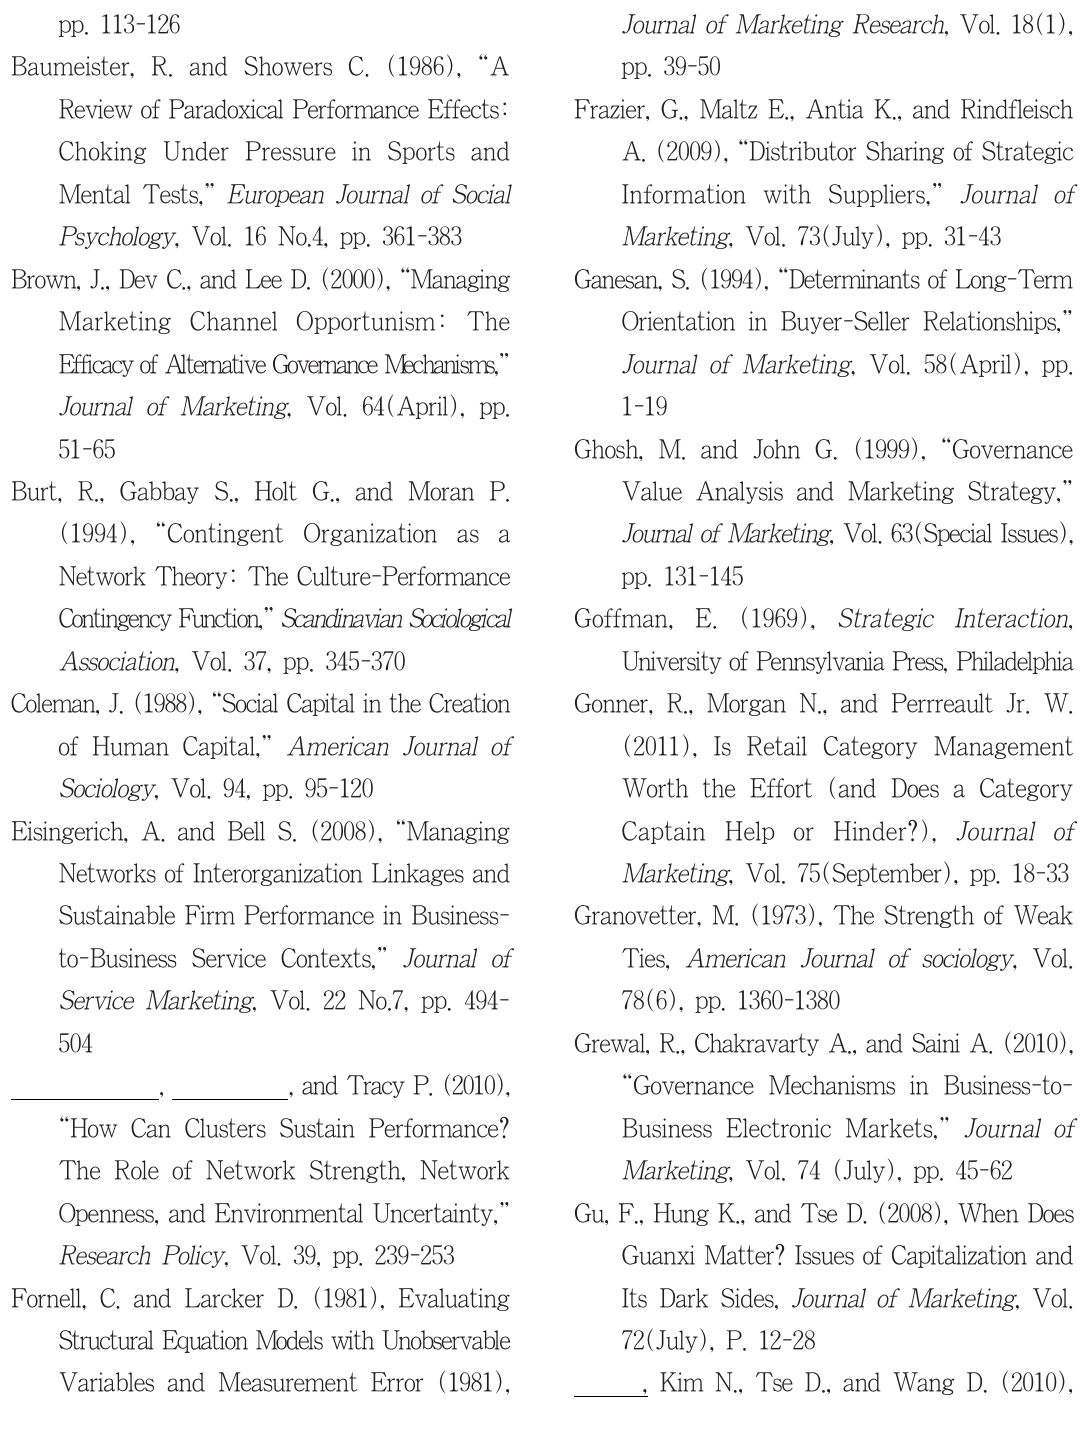
How Network Structure Impacts Firm Performance: The Moderating Effect of Network Openness and Interfirm Governance